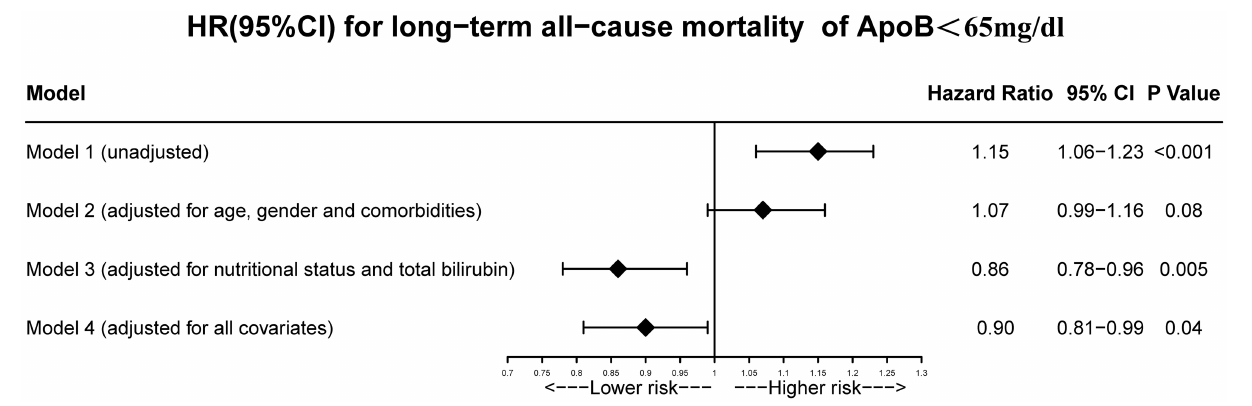
FIGURE 4 | Unadjusted and adjusted HRs and 95% CIs for the primary end point (long-term all-cause mortality) of ApoB < 65 mg/dL group vs. ApoB ≥ 65 mg/dL group in CAD patients. Model 1: Unadjusted model. Model 2: Adjusted for age ≥ 75 years, sex, PCI and comorbidities including AMI, CHF, hypertension, diabetes mellitus, CKD, anemia, atrial fibrillation, COPD and stroke. Model 3: Adjusted for malnutrition. Model 4: Adjusted for all covariates: age ≥ 75 years, sex, PCI and comorbidities including AMI, CHF, hypertension, diabetes mellitus, CKD, anemia, atrial fibrillation, COPD, stroke and malnutrition.